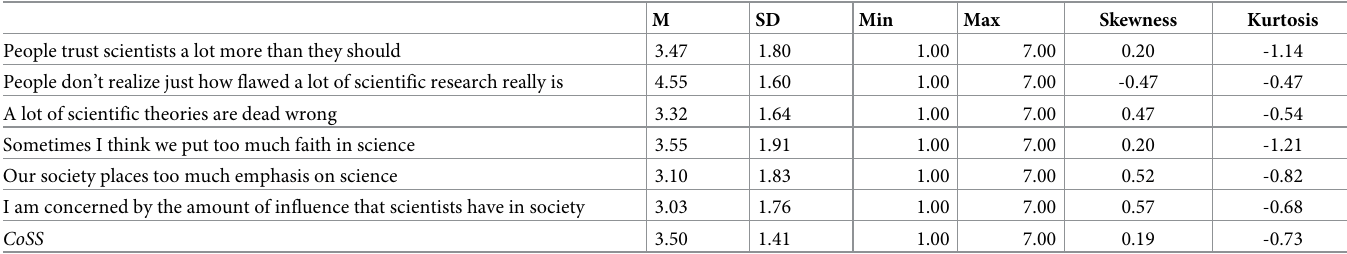
Table 5. Descriptive statistics of the items on the CoSS–Study 1C.